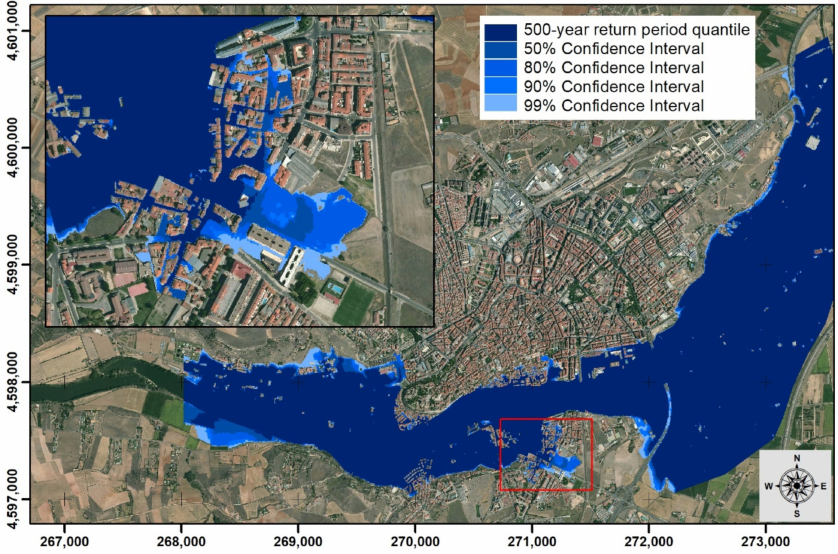
Figure 4. Probabilistic map of flood prone areas in Zamora city (Spain). The red square defines the area exposed in the zoom